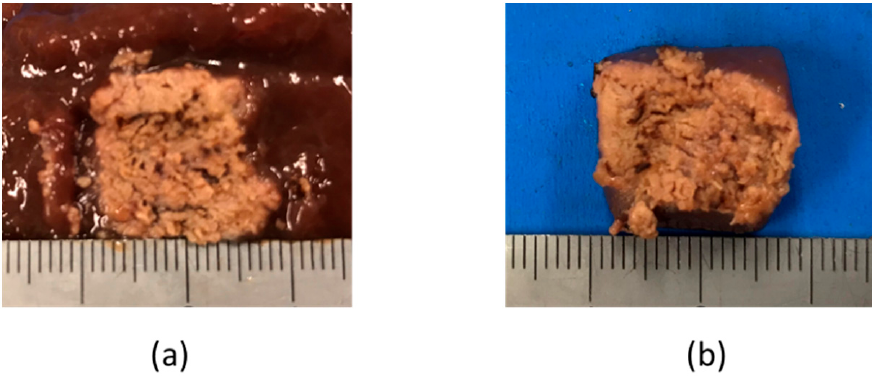
Figure 13. Heating with the high frequency current snare.